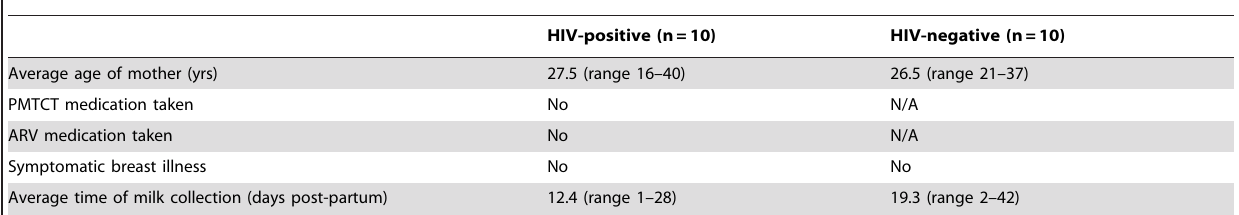
Table 1. Characteristics of Tanzanian breast milk donors.